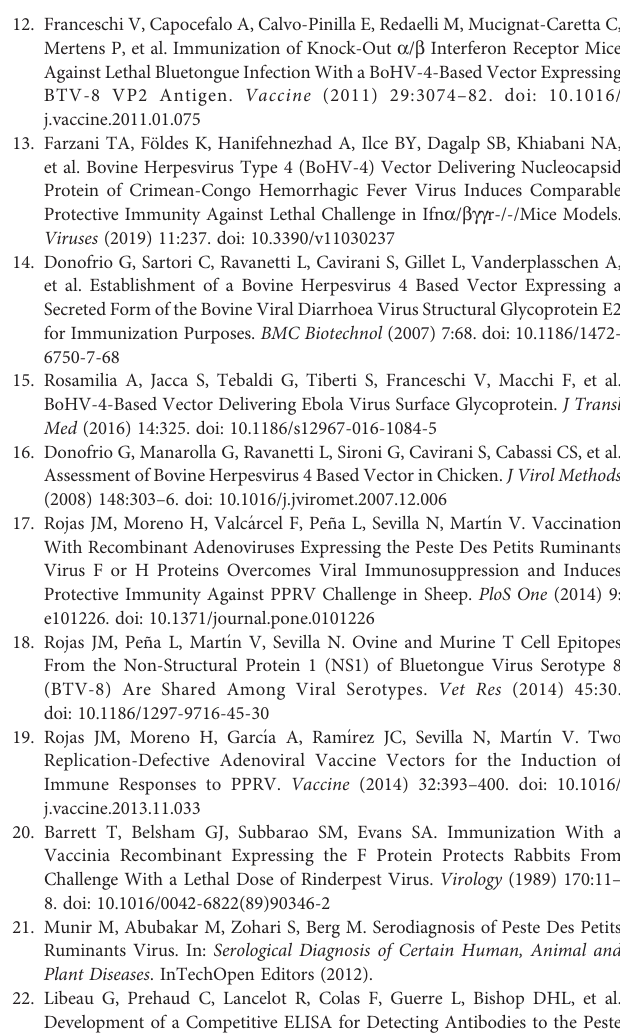
Supplementary Figure 1 | MTT assay comparing OFLs growth with medium containing 10% of FBS and the same number of OFLs growth with medium containing 10% of sheep serum, at different time points (24, 48 and 72 hours). In (A) absolute valuesare expressed asoptical density (O.D.),whereas in (B) the same data were normalized and expressed as percentage of cell growth, where the cell growth with FBS was considered equal to 100% of growth. The data presented are the means ± standard errors of triplicate measurements. Supplementary Figure 2 | Flow chart of the strategy used to produce BoHV-4- A-PPRV-H- D TK and BoHV-4-A- D TK free of bovine